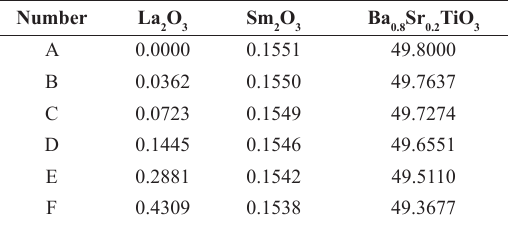
Table 1. Chemical composition of the samples (g)